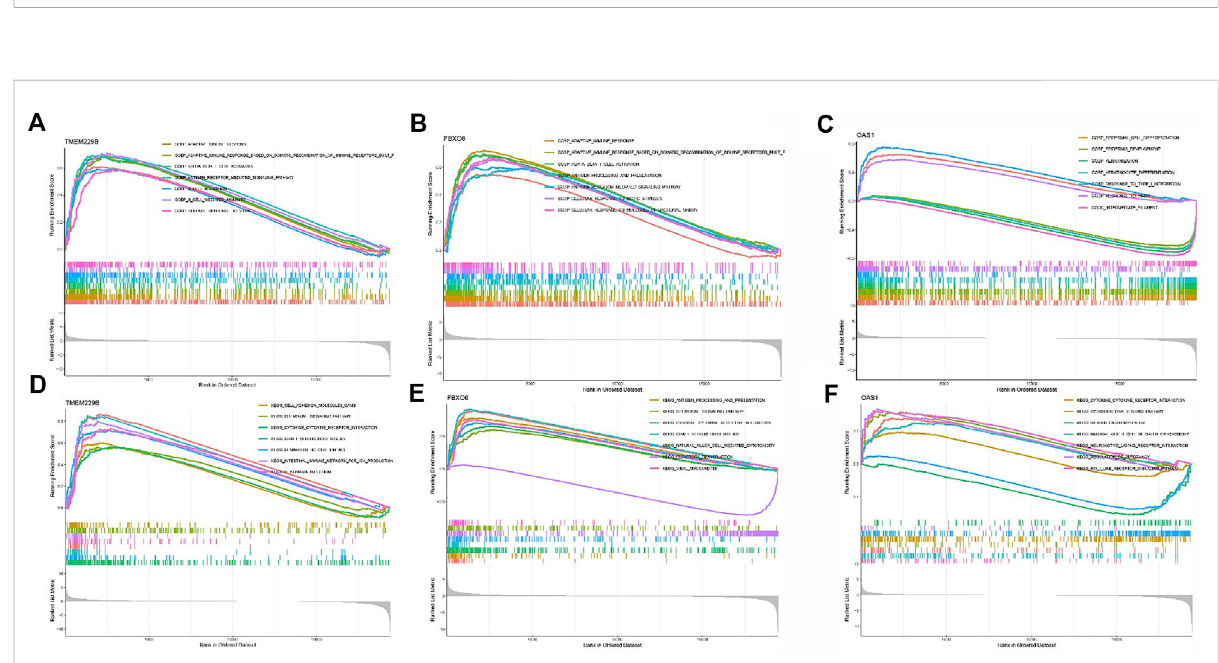
FIGURE 3 (A) The enriched gene sets in GO collection by the high TMEM229 expression sample. (B) The enriched gene sets in GO collection by the high FBXO6 expression sample. (C) The enriched gene sets in GO collection by the high OAS1 expression sample. (D) The enriched gene sets in